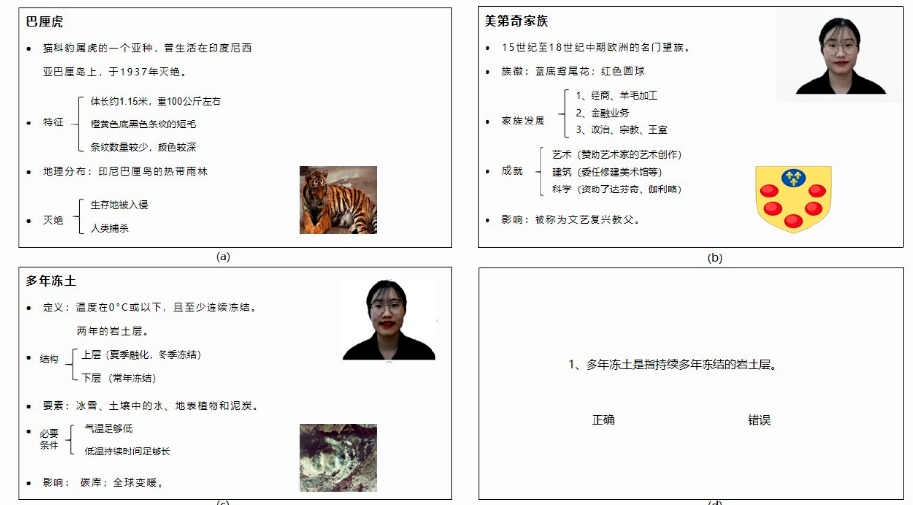
Figure 1. Screenshots of the videos in the ( a ) audio-video condition (AV), ( b ) picture-video condition (PV), ( c ) video-video condition (VV), and ( d ) one comprehension question following a video.